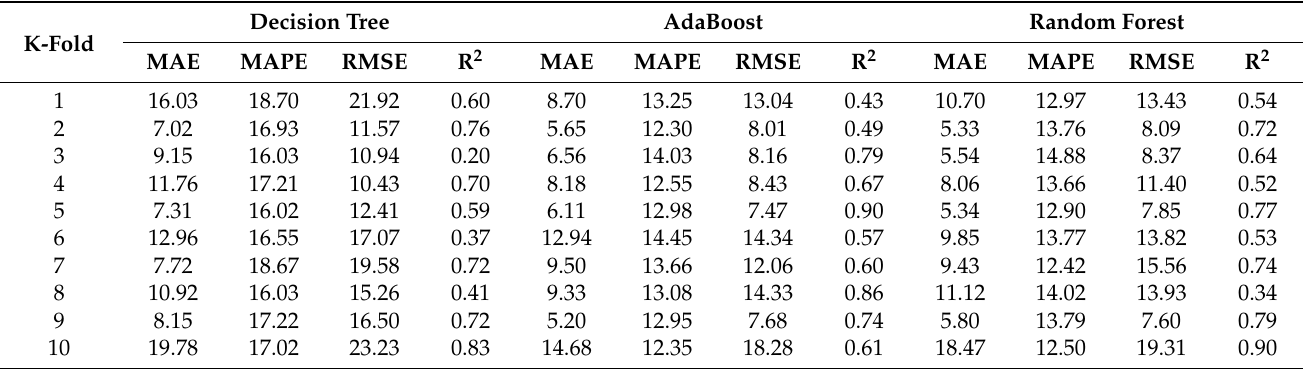
Table 3. Outcomes of k-fold